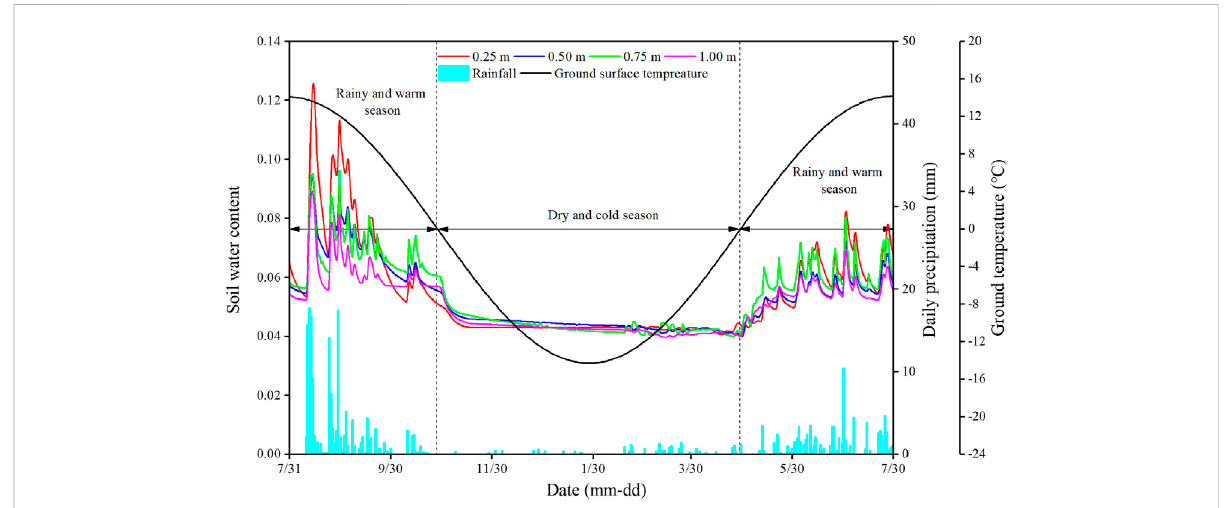
FIGURE 8 The evolution of water content of soil 0.10 m below the sand surface in the 20th